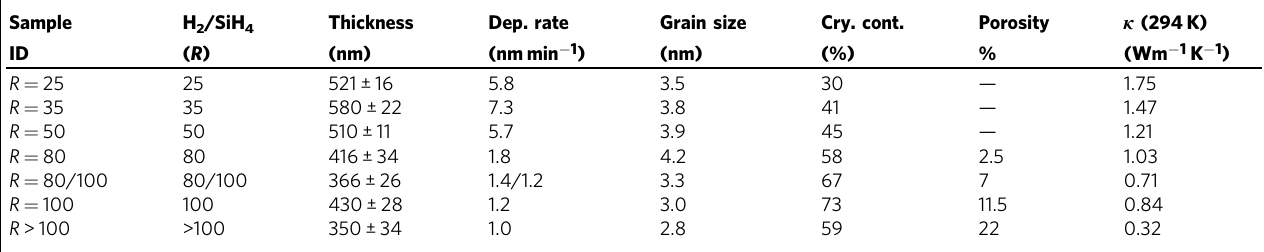
Table 1 Plasma-enhanced chemical vapor-deposited nc -Si fi lm: names, parameters, and thermal conductivity at 294 K. Sample H 2 /SiH 4